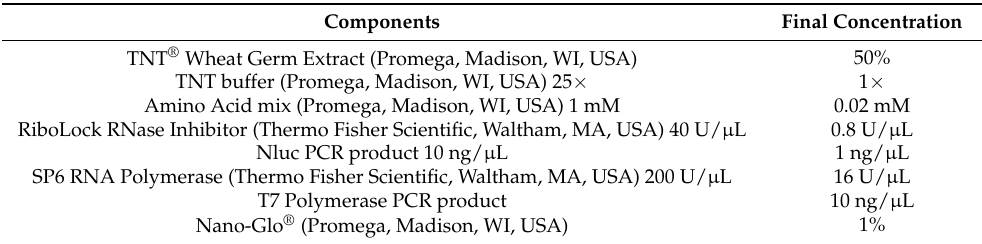
Table 2. Components of the coupled 2